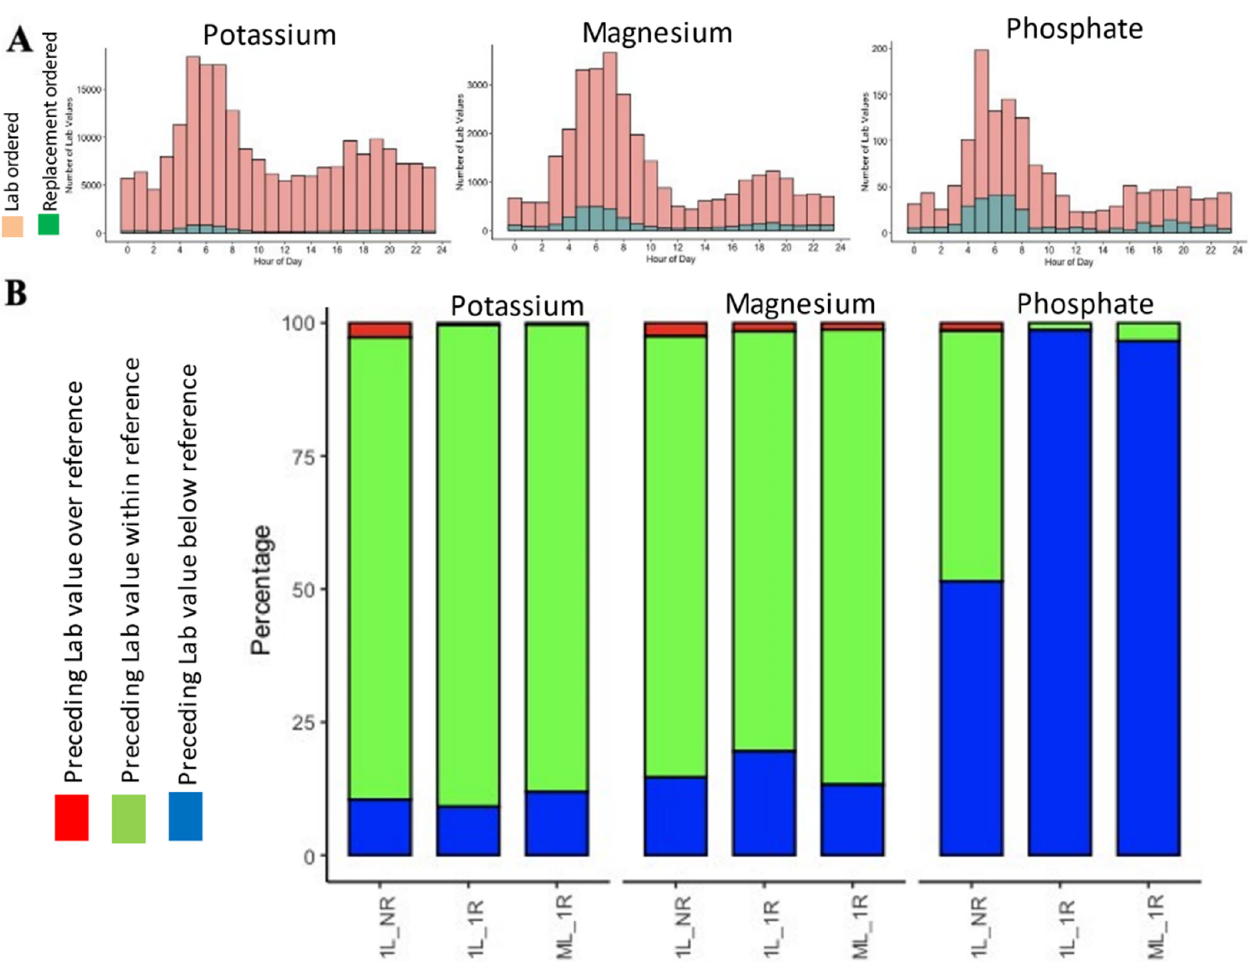
Figure 3. Only a minority of the lab values resulted in clinical intervention ( A ). In the case of potassium and magnesium repletion, trigger values were within the normal limit but not in the case of hypophosphatemia, which was a more frequent trigger for replacement than the normal phosphate level ( B ).